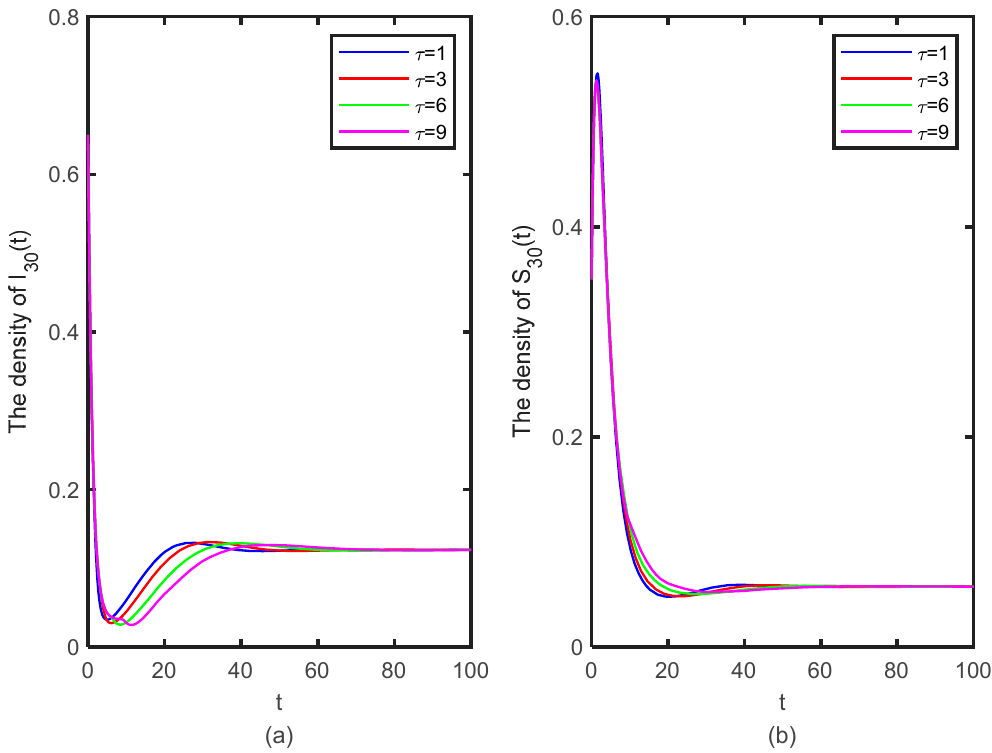
Figure 8. The densities of I 30 ( t ) ( a ) and S 30 ( t ) ; ( b ) for different time delays when R 0 >